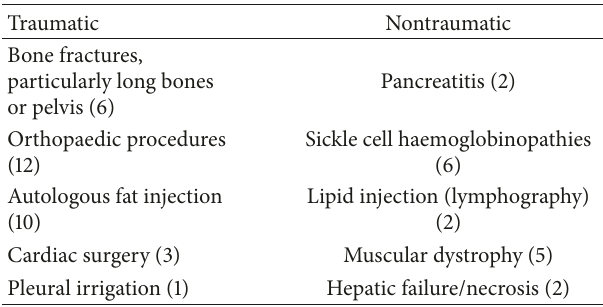
Table 2: Causes of cerebral fat embolism (number of case reports with specific etiology